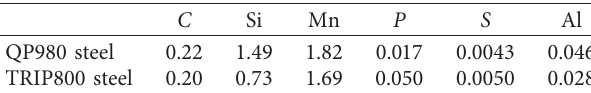
Figure 10: Microhardness profile. (a) QP980 steel RSW; (b) TRIP800 steel RSW. Table 2: Chemical composition of two-grade